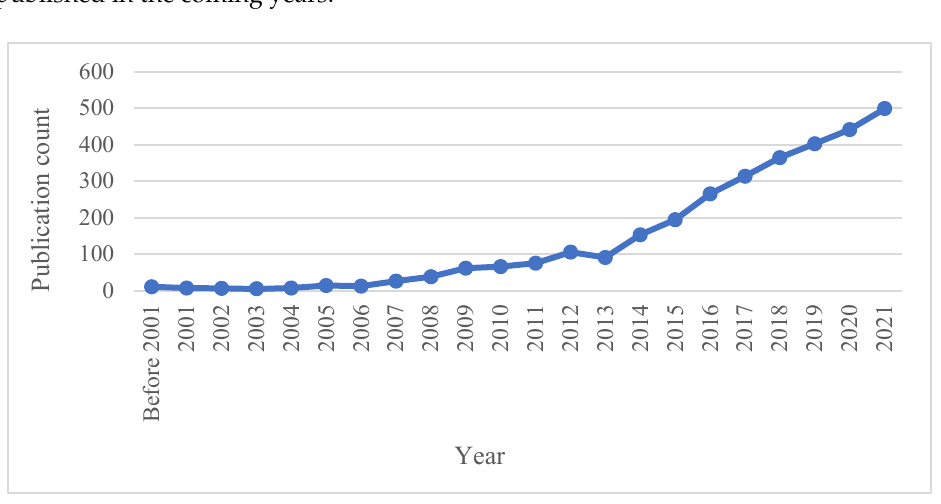
Table 2. List of conferences and counts.